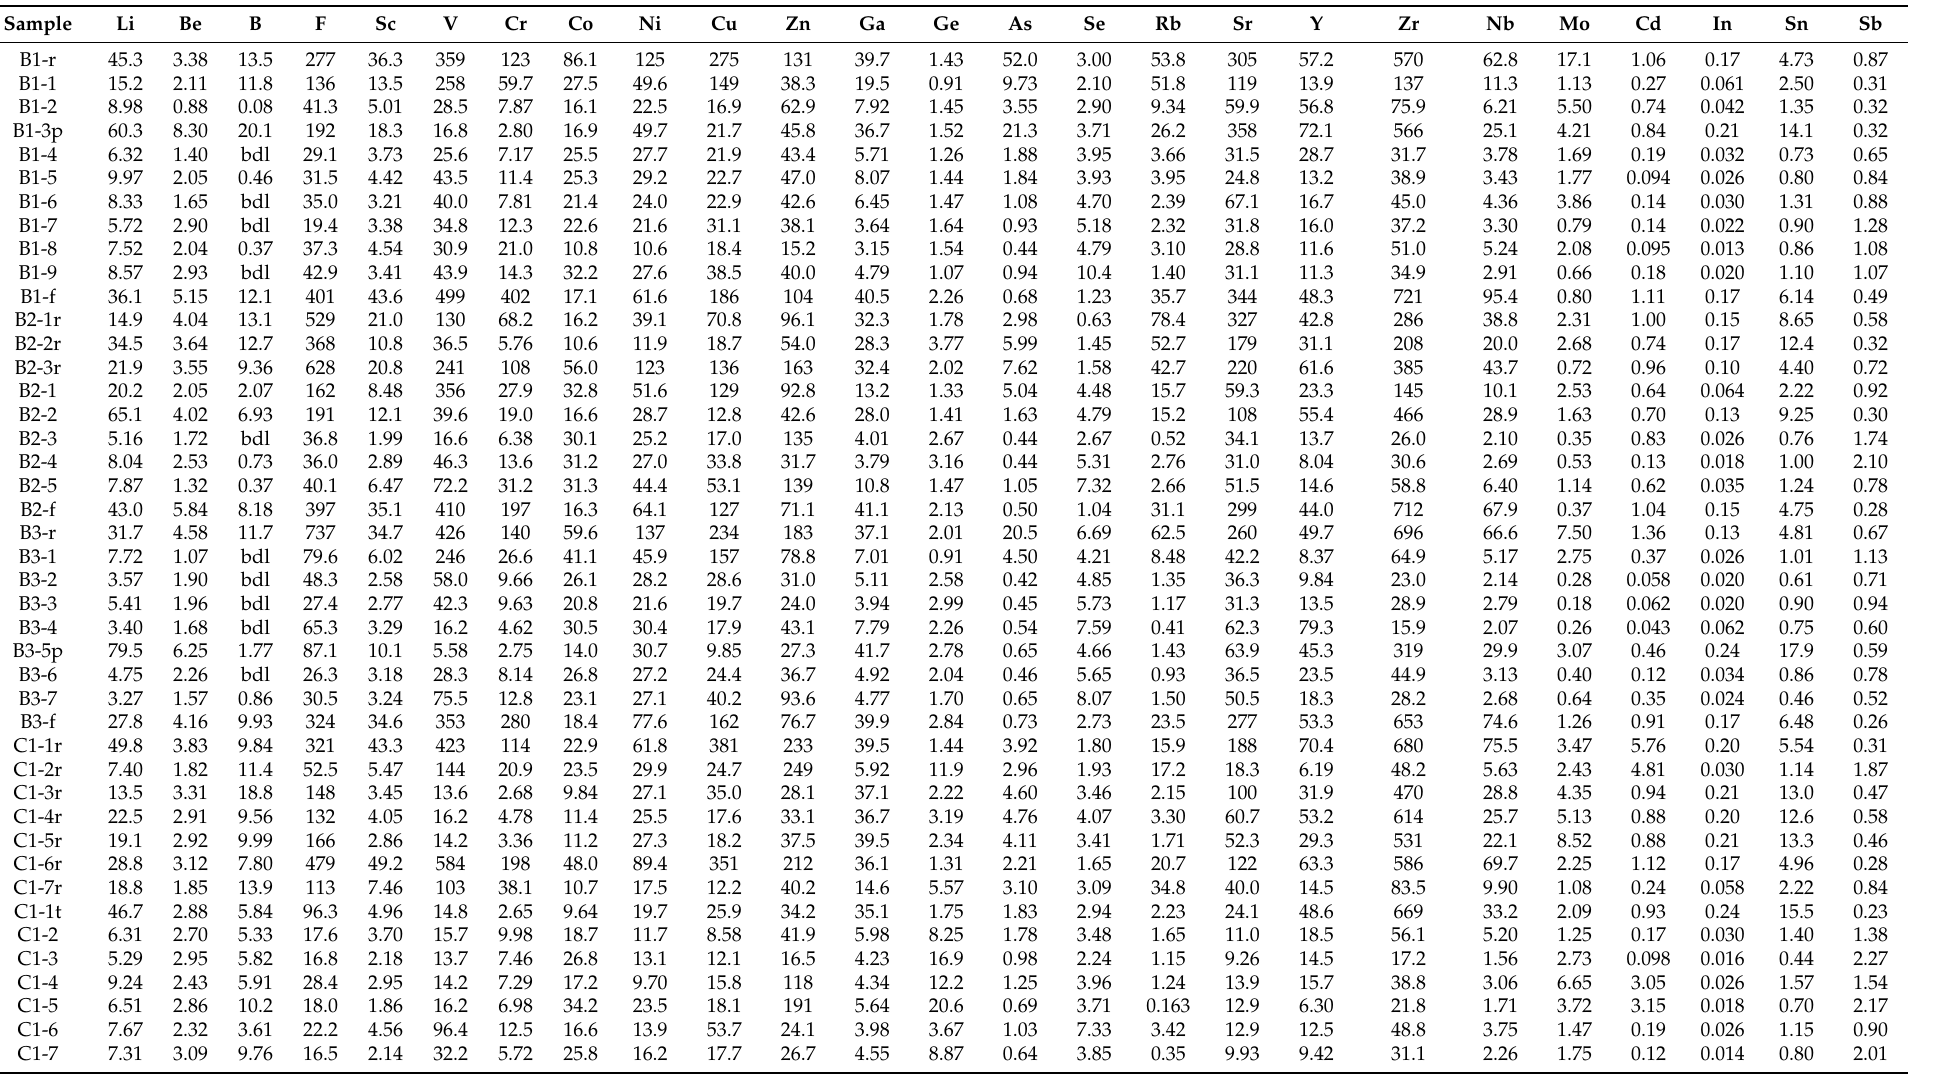
Table 4. Concentrations of trace elements ( µ g/g, Hg in ng/g) in the Bole and Laibin coal benches, partings, and roof and floor strata